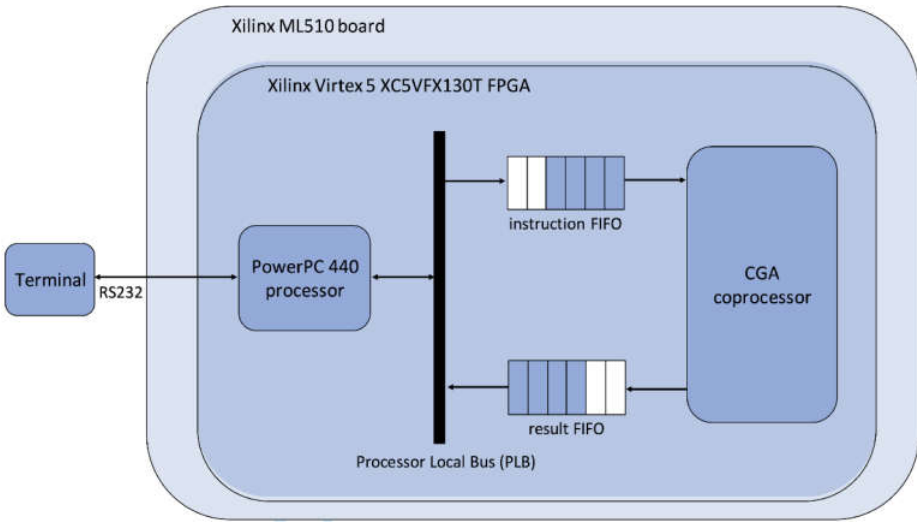
Figure 2. CGA coprocessor prototype on the Xilinx ML510 board.